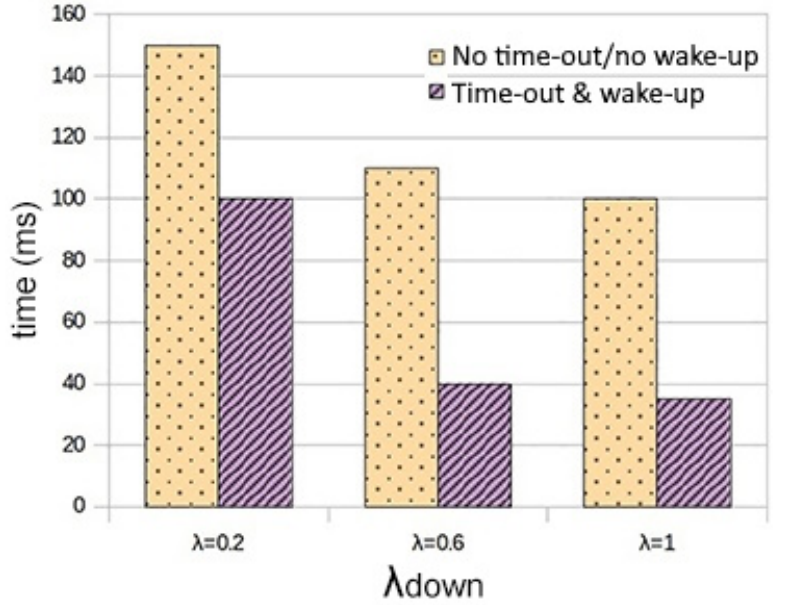
Figure 5. Time required for proposed model and model [21] to be completed with probability of 1 when λ down varies from 0.2 to 1 and λ up =